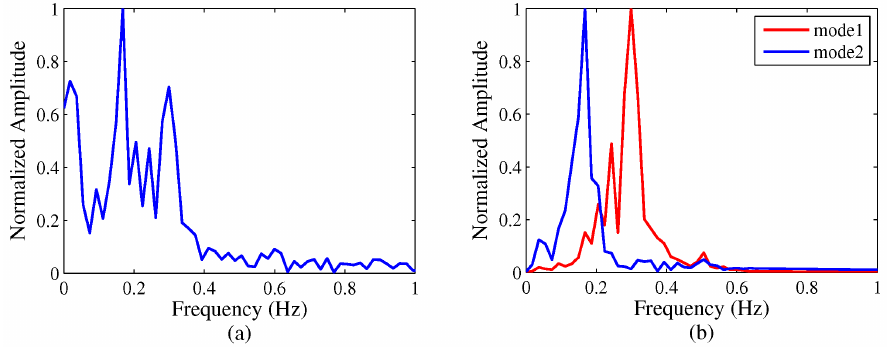
Figure 4. Traditional FFT method ( a ) versus the variational mode decomposition ( VMD )-based method ( b )